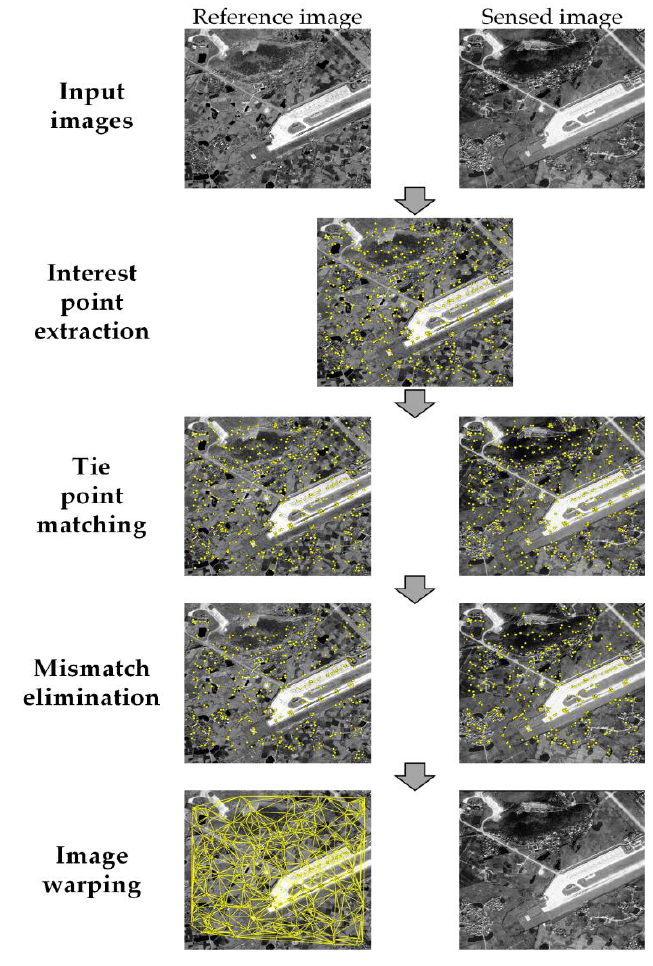
Figure 2. Flowchart of the fine registration method based on the enhanced phase correlation (PC) matching.